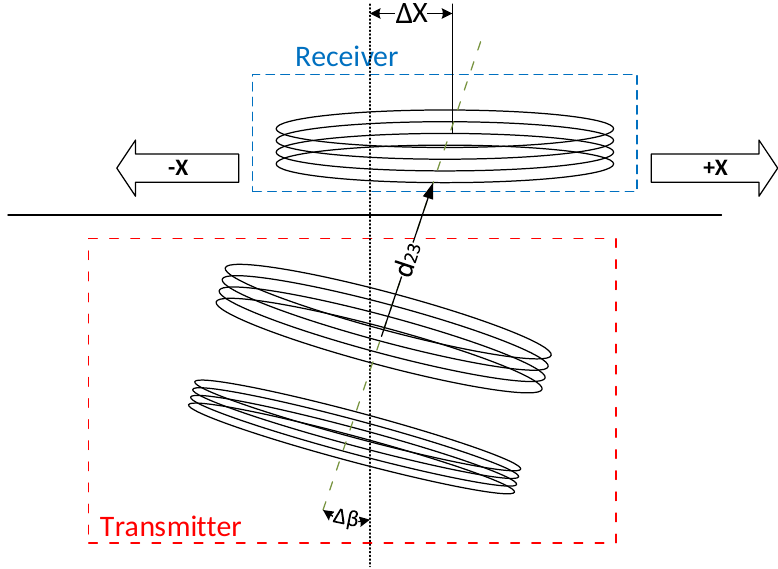
Figure 17. Diagram of the proposed WPT charger